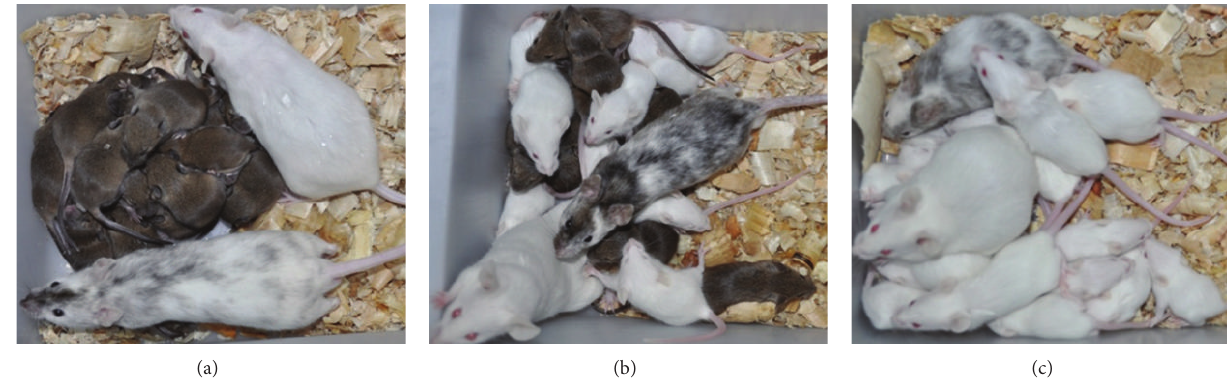
Figure 6: Germline transmission of mouse chimeras derived from ESCs. Fully (a), partially (b), and no (c) germline transmitted chimeric mice are shown by the colors of their pups.